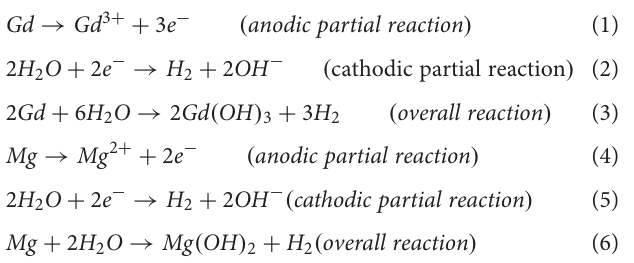
FIGURE 14 | Mechanism of micro-galvanic corrosion proposed for Mg-10Gd alloy: (A) formation of Gd and Mg hydroxides on the surface in as-cast condition, (B) degradation of the Mg matrix adjacent to Mg 5 Gd phases, (C) higher dissolution of Mg matrix, exposing the Mg 5 Gd/GdH 2 phases subsequently starts the dissolution of Mg 5 Gd phase due to reducing contact area, (D) detachment and dissolution of Mg 5 Gd/GdH 2 phases, and (E) localized micro-galvanic corrosion at preferential areas for samples heat